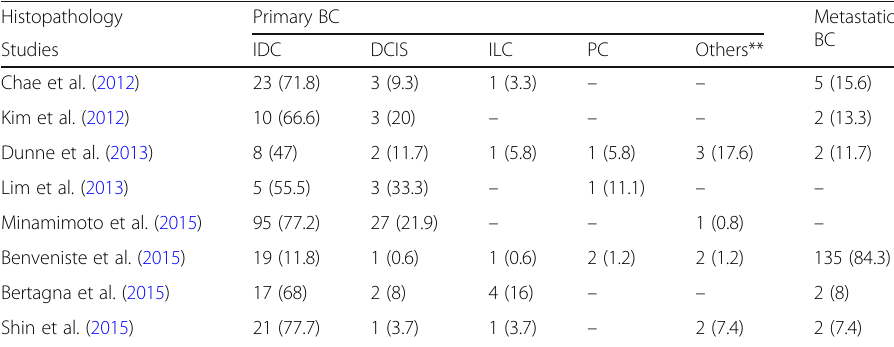
Table 3 Histopathological characteristics of patients with breast cancer*